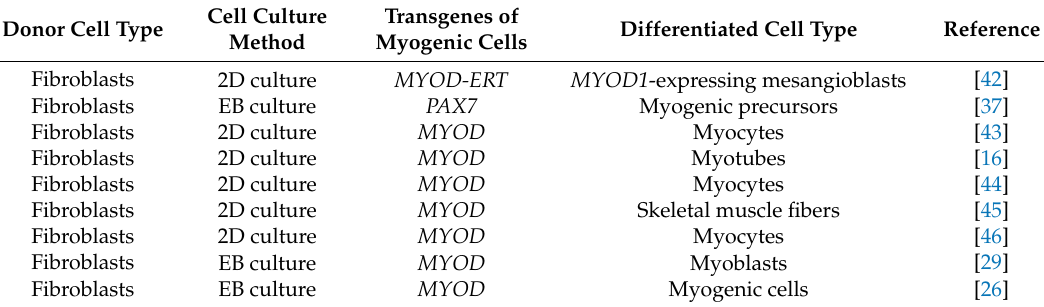
Table 2. Transgene myogenic induction of induced pluripotent stem cells (iPSCs).